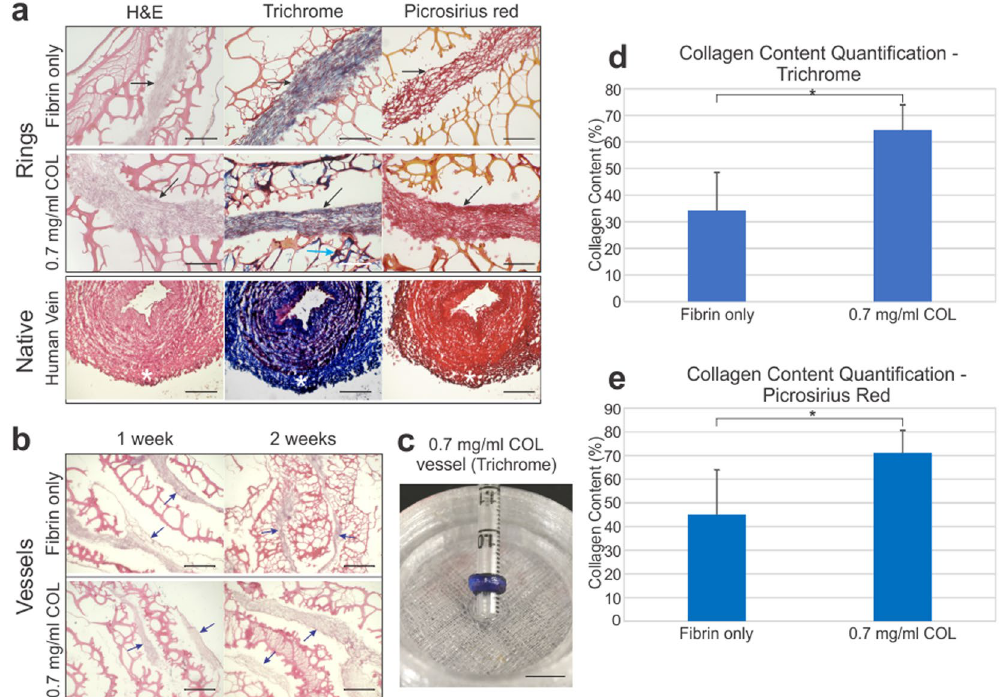
Figure 5. Histology of Fibrin only and 0.7 mg/ml collagen adventitia rings and vessels. ( a ) Collagen is present in H&E (pink), Masson’s Trichrome (blue/purple), and Picrosirius red (red) stains in ring cross-sections. Cell + collagen areas (black arrows) appears thicker and more dense in the 0.7 mg/ml COL rings compared to the Fibrin only rings. Additionally, collagen was present in the hydrogel on the periphery of the cellular region (Trichrome image, light blue arrow). Native human vein histological samples are shown for comparison; the adventitia layer is located on the outer edge of the native vein (white asterisk). The organization and density of the collagen in the engineered adventitia appears similar to that of the native vein. Engineered vessel scale bars = 200 µ m. Native vein scale bars = 100 µ m. ( b ) Longitudinal sections stained with H&E show the alternating organization of cells (blue arrows) and hydrogel along the ring stacked vessels in Fibrin only and 0.7 mg/ml COL vessels at 1 and 2 week culture times. Scale bars = 250 µ m. ( c ) Masson’s Trichrome stain of a 3-ring stack of 0.7 mg/ml COL rings show the presence of (blue) collagen throughout the vessel. Scale bar = 1 cm. Collagen content quantification was performed using data from ( d ) Trichrome staining and ( e ) Picrosirius red staining. Collagen content was significantly higher in the 0.7 mg/ml COL rings compared to the Fibrin only rings (p < 0.0001). * Denotes statistical